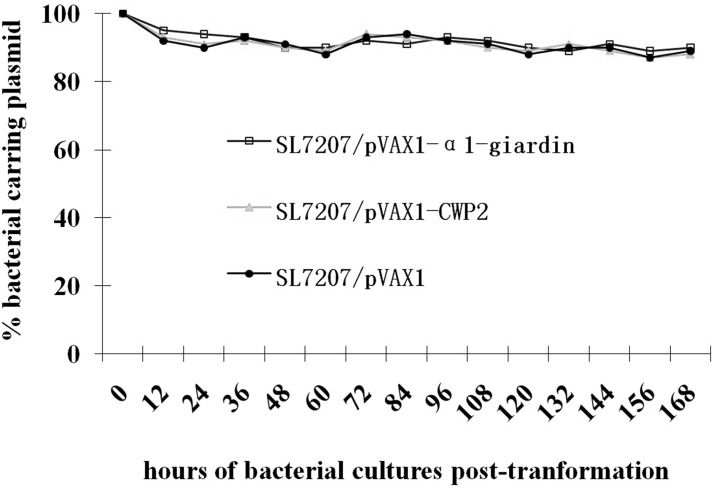
Stability of recombinant plasmid.pVAX1-α1-giardin and pVAX1-CWP2 or pVAX1 alone in transformed SL7207 cultured for 168 hours in antibiotic-free media. The stability was determined by the percentage of bacteria containing the plasmid on kanamycin-LB agar plant compared to the total count on a plate without kanamycin.